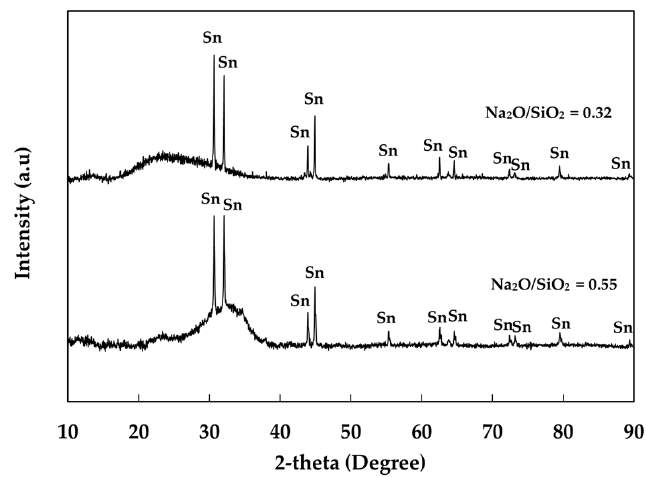
Figure 3. XRD patterns of slag produced after experiments.